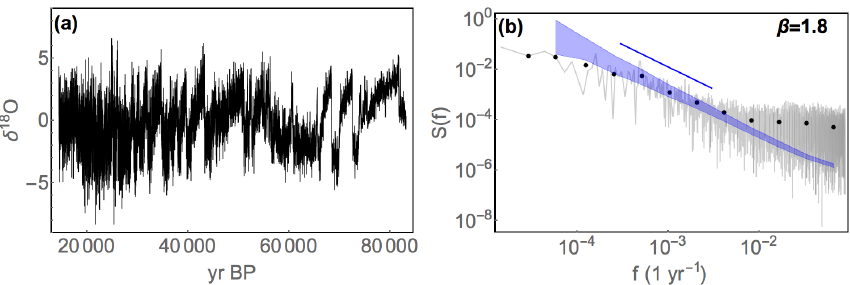
Figure 12. (a) δ 18 O anomaly time series from the last glacial period of the high-resolution GRIP ice core. (b) Periodogram for the time series in (a) .